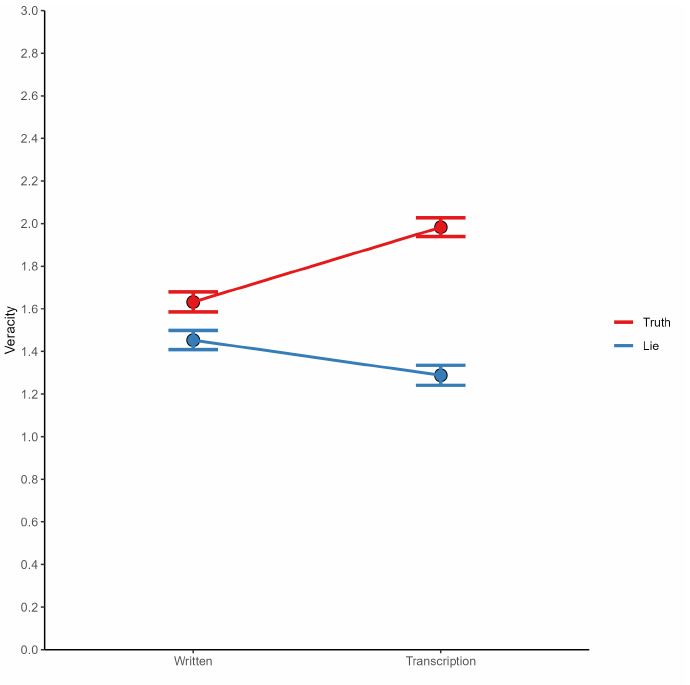
Figure 1. The plot presents the mean scores of statement veracity according to the status and the form of statement. Error bars represent standard